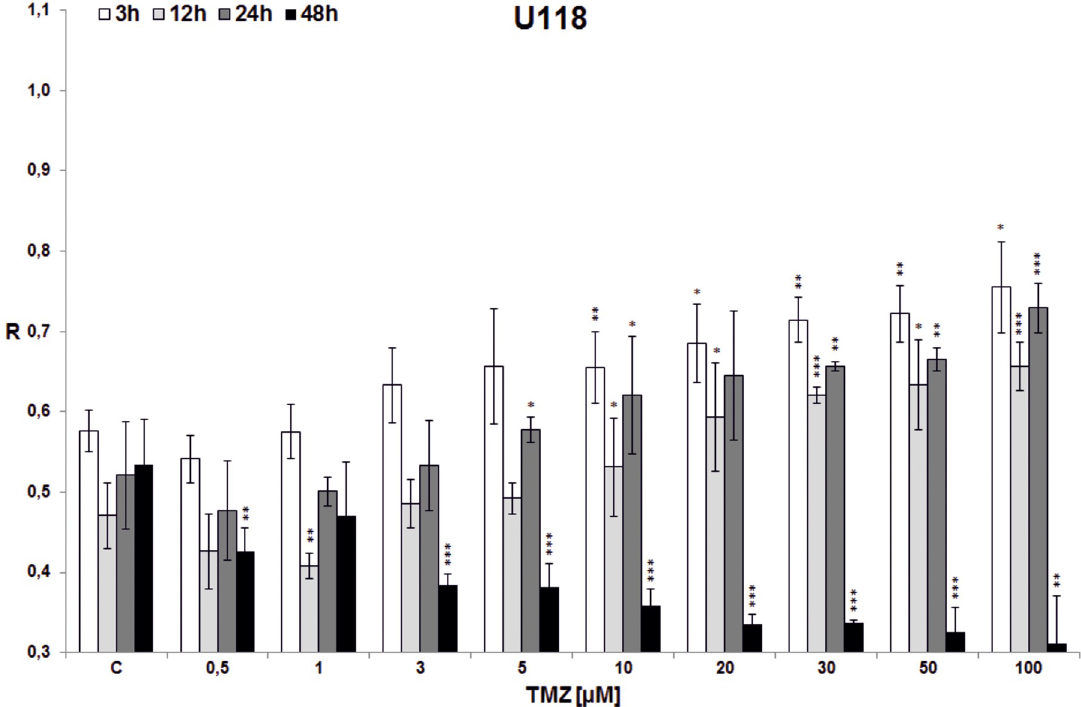
Fig 5. The effect of TMZ on total DNA methylation of U118 cell line. The analysis was performed after 3 (white bars), 12 (light grey bars), 24 (dark grey bars) and 48 (black bars) hrs of incubation in a given TMZ concentration (0.5–100 μ M). Control cells (C) were treated with DMSO only. The R values are means from three experiments ± SD. Asterisks indicate a significant difference ( � p < 0,05, �� p < 0,01, ��� p < 0,001) from the control (DMSO) value. Significant demethylating tendency is seen with 48 hrs incubation time in all TMZ concentrations. The TMZ amount needed to reach hypermethylating effect depends on incubation time and is within the range 1–10 μ M.